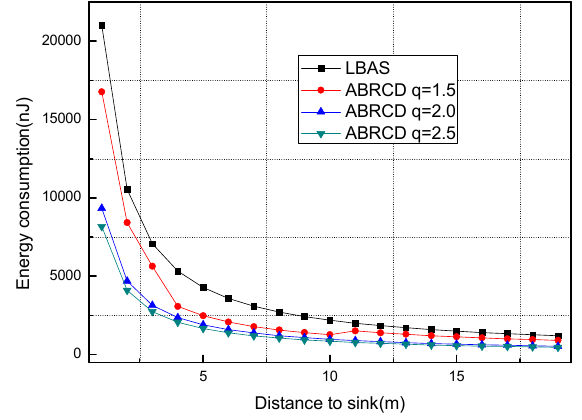
Figure 18. Energy consumption of nodes 1~19 m away from sink with different q (1.5, 2.0 and 2.5).